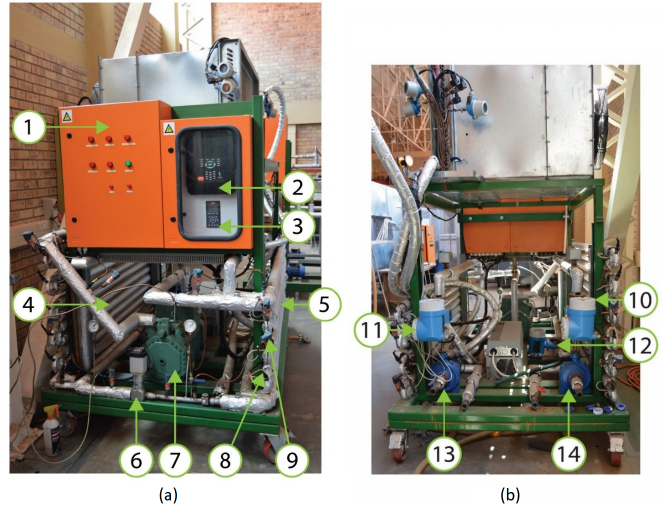
Figure 3. Heat pump test facility: ( a ) from front, ( b ) from